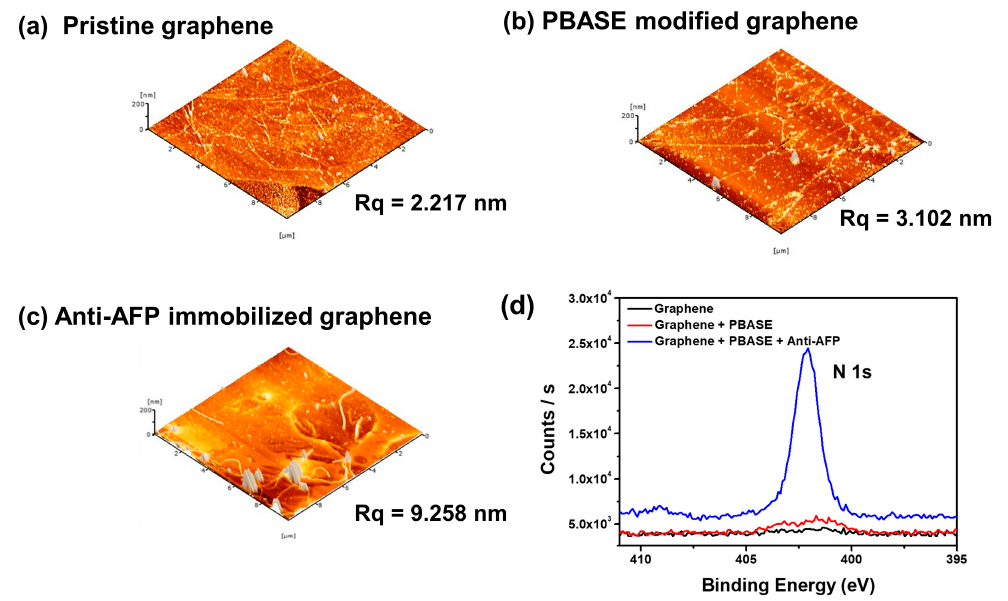
Figure 2. 3D AFM images of ( a ) pristine graphene; ( b ) PBASE-modified graphene; ( c ) anti-AFP-immobilized graphene; ( d ) high-resolution XPS N1s spectra of pristine, PBASE-modified, and anti-AFP-immobilized graphenes.